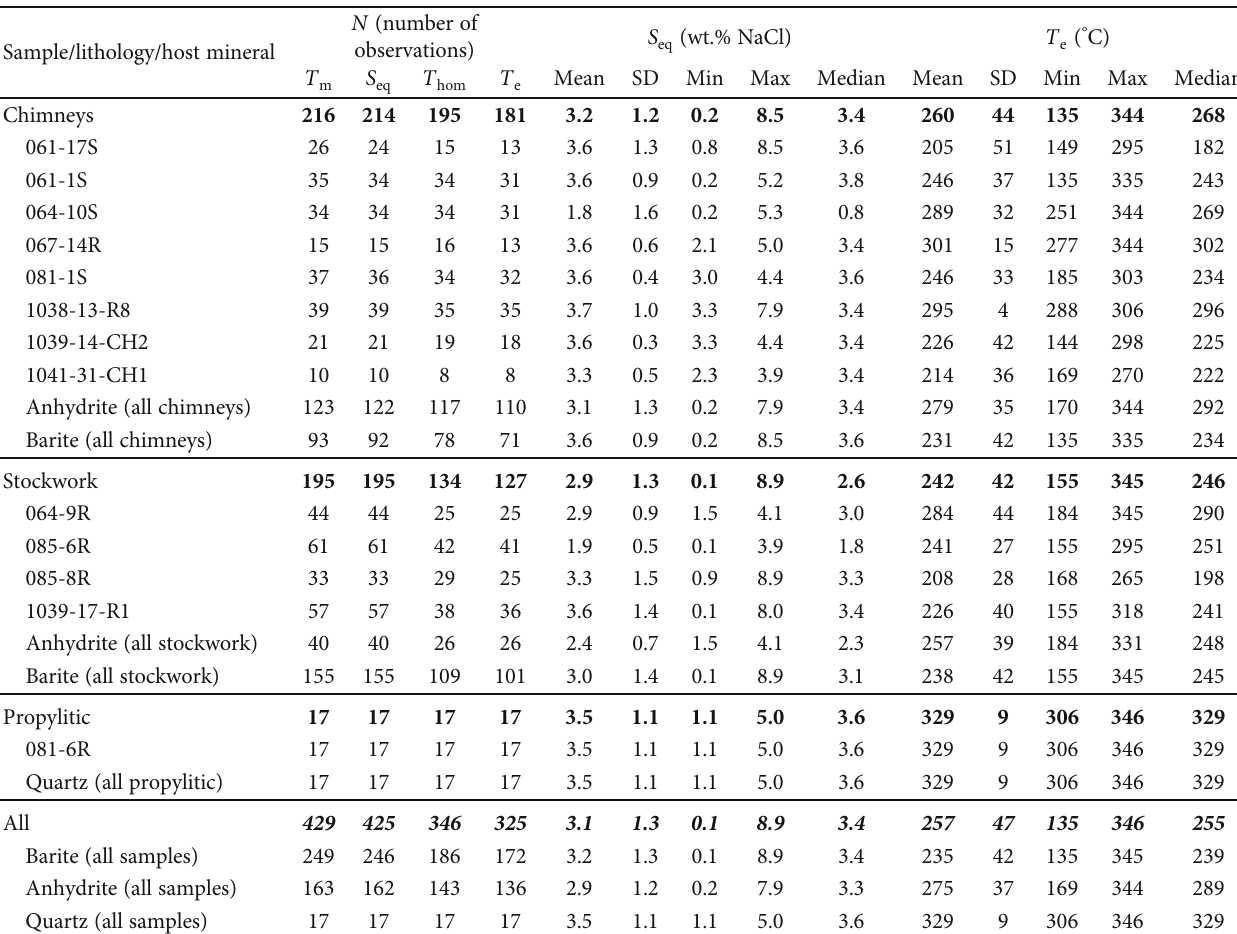
higher than that of pure water (+1.8 ° C and +3.3 ° C) are m than mentioned in the text above. eq